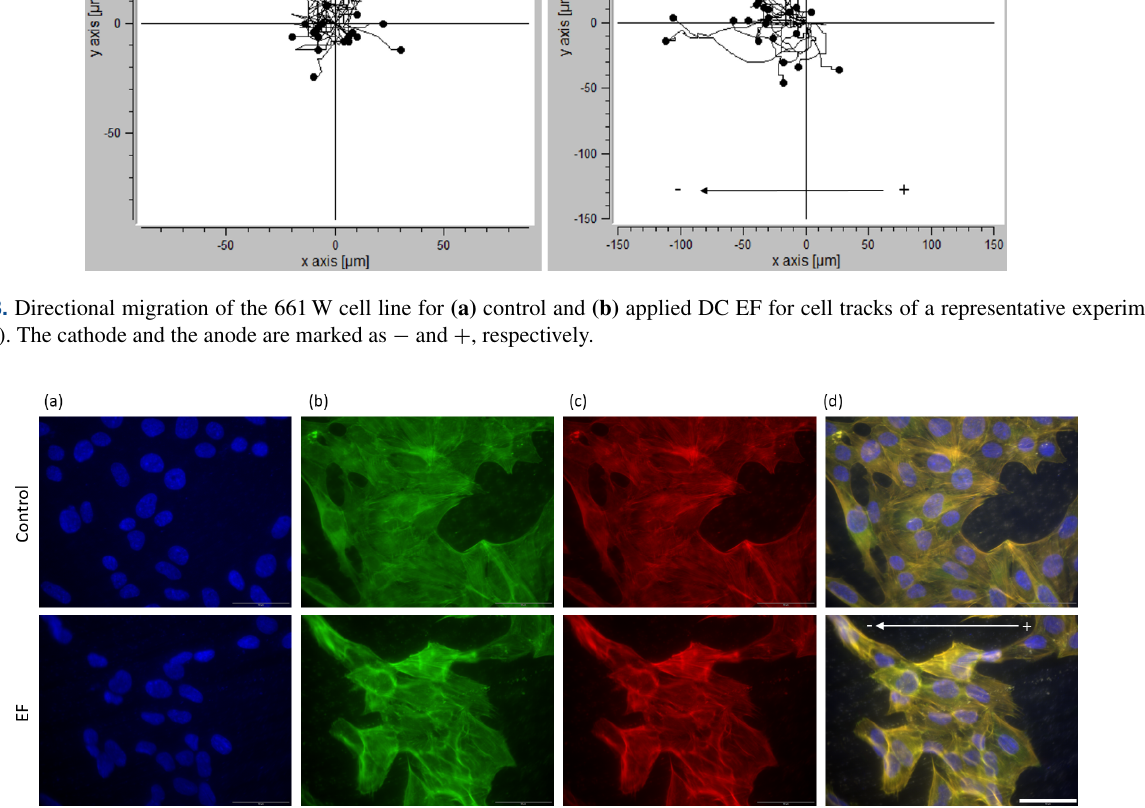
Figure 4. Morphology of 661W on the PET membrane for control and after 120min of applied EF. Cells were labelled for (a) nucleus, (b) vinculin, (c) filamentous actin cytoskeleton, and (d) merged image. The direction of the arrow shows the direction of the cathode and anode positions. Scale bar